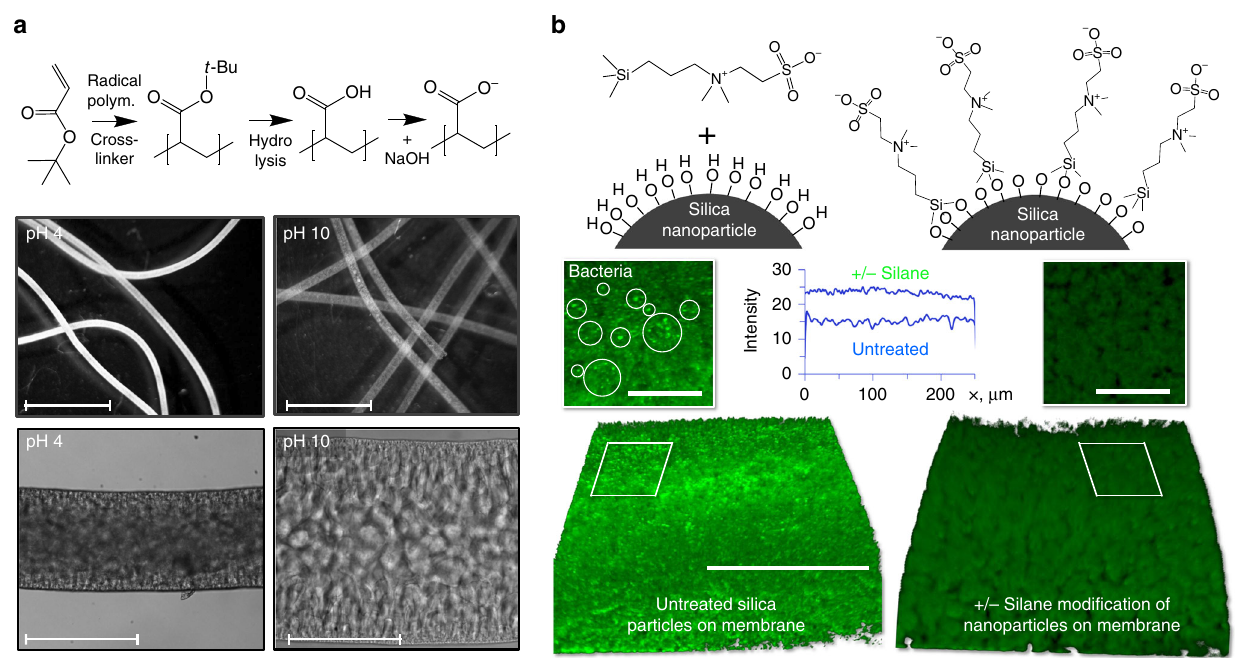
Fig. 4 Additional features of STRIPS-bijel derived membranes. a Formation of pH-responsive poly(acrylic acid) hydrogel fi bers by hydrolysis of fi bers composed of HDA cross-linked poly( tert -butylacrylate). The photo- and micro- graphs show the fi bers unswollen at pH 4 and swollen at pH 10. Scale bars upper micrographs 2 mm, scale bar lower micrographs 200 µ m. b Zwitterionic silane functionalization of the densely-packed silica nanoparticle surface of the membranes. Three dimensional confocal micrographs show that the unmodi fi ed membranes (having a faint green fl uorescence themselves) are partially coated by bright speckles of green- fl uorescent Streptococcus mutants (see inset), while the zwitterionic silane-functionalized membrane does not show signi fi cant bacteria adhesion. The inset diagram shows the comparison of the average fl uorescence intensity along the length of both membranes. Both membranes have been imaged at the same settings for confocal micrograph acquisition. Scale bar isometric membrane perspective 50 µ m, scale bar magni fi ed insets 20 µ whereas for 0.38 g silica /g dry fi ber the average pore size becomes about 500 nm. This fi nding indicates that higher silica concentra-